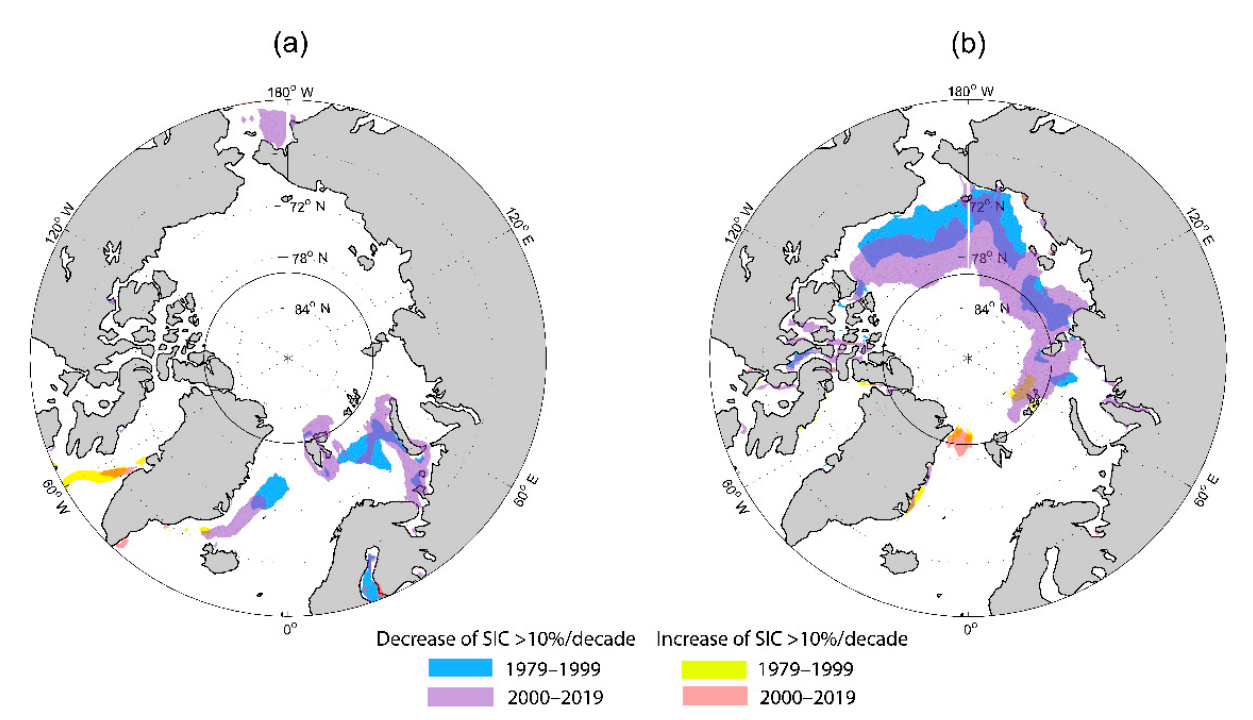
Figure 5. Areas of noticeable SIC trends (more than 10% per decade) in 1979–1999 and 2000–2019 for ( a ) March and ( b ) September (Black circle shows 80° N latitude). All indicated (shaded) trends are statistically significant ( p < 0.1).